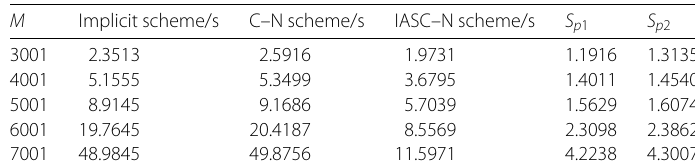
Table 4 Computing time and speedup of scheme solution ( α = 0.7)